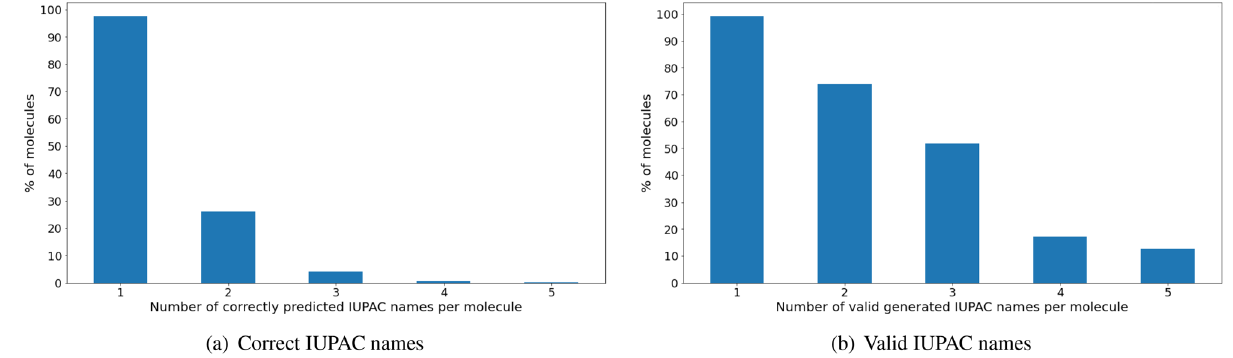
Figure 8. The distribution of the number of names variations using a Transformer’s beam search.